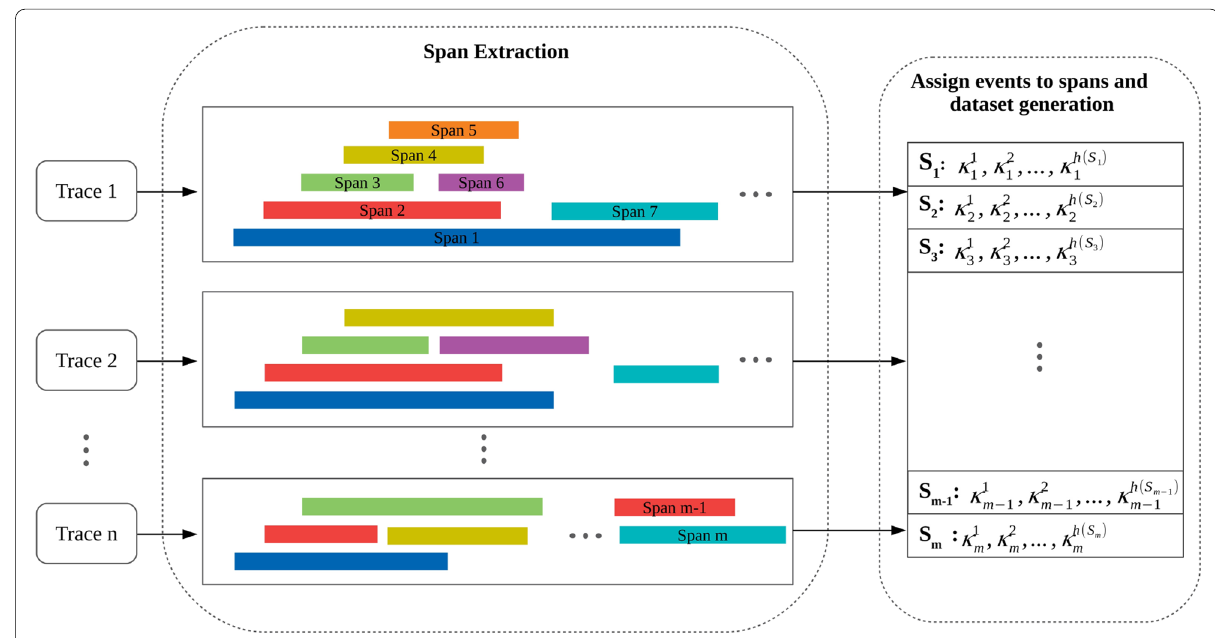
Fig. 3 Illustration of the process for creating the training dataset from multiple